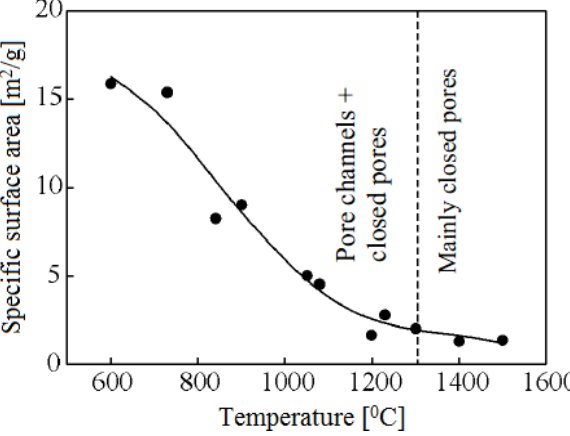
Figure 37. Specific surface area of sintered polycrystalline TiN as a function of sintering temperature.